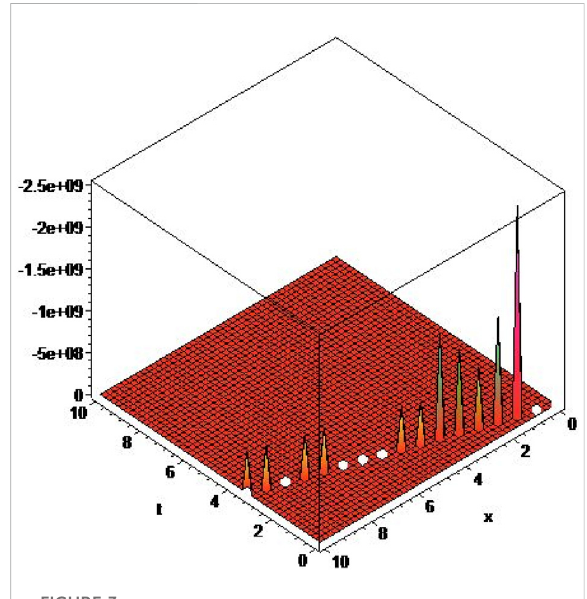
FIGURE 3 Figure of u7 in (Eq. 4.20) with a0 = 1/2, 0 < t < 10, and 0 < x <